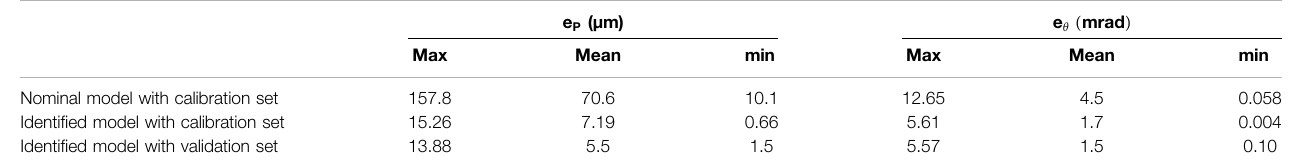
TABLE 3 | Positioning and orientation errors (respectively e P and e θ ) with the nominal or the identi fi ed parameters and for the calibration or the validation con fi guration